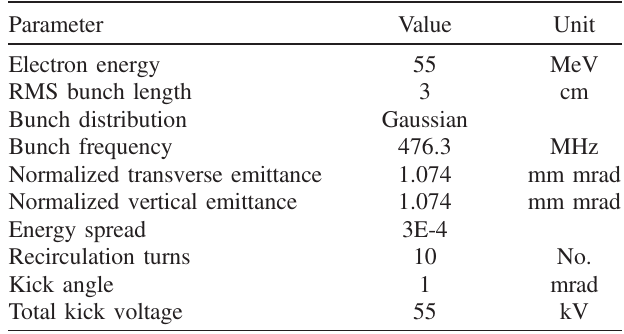
TABLE II. Input parameters in ELEGANT